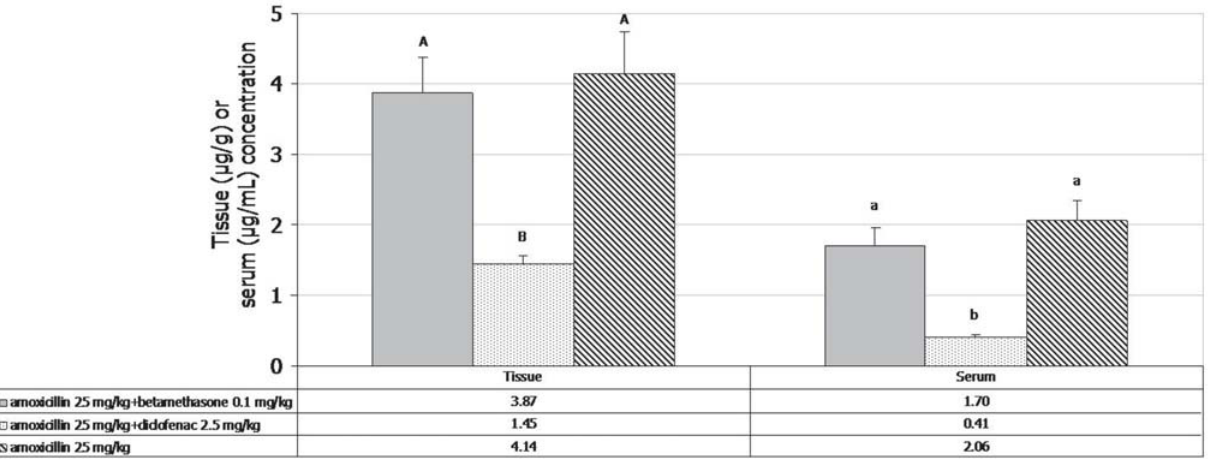
FIGURE 1- Amoxicillin serum and tissue concentrations (mean ± s.e.m.) considering groups 1, 4 and 5. Groups 2, 3 and 6 did not show any inhibition zone considering both serum and tissue samples. Different letters mean statistically significant differences (p<0.05) among groups, considering serum and tissue concentrations